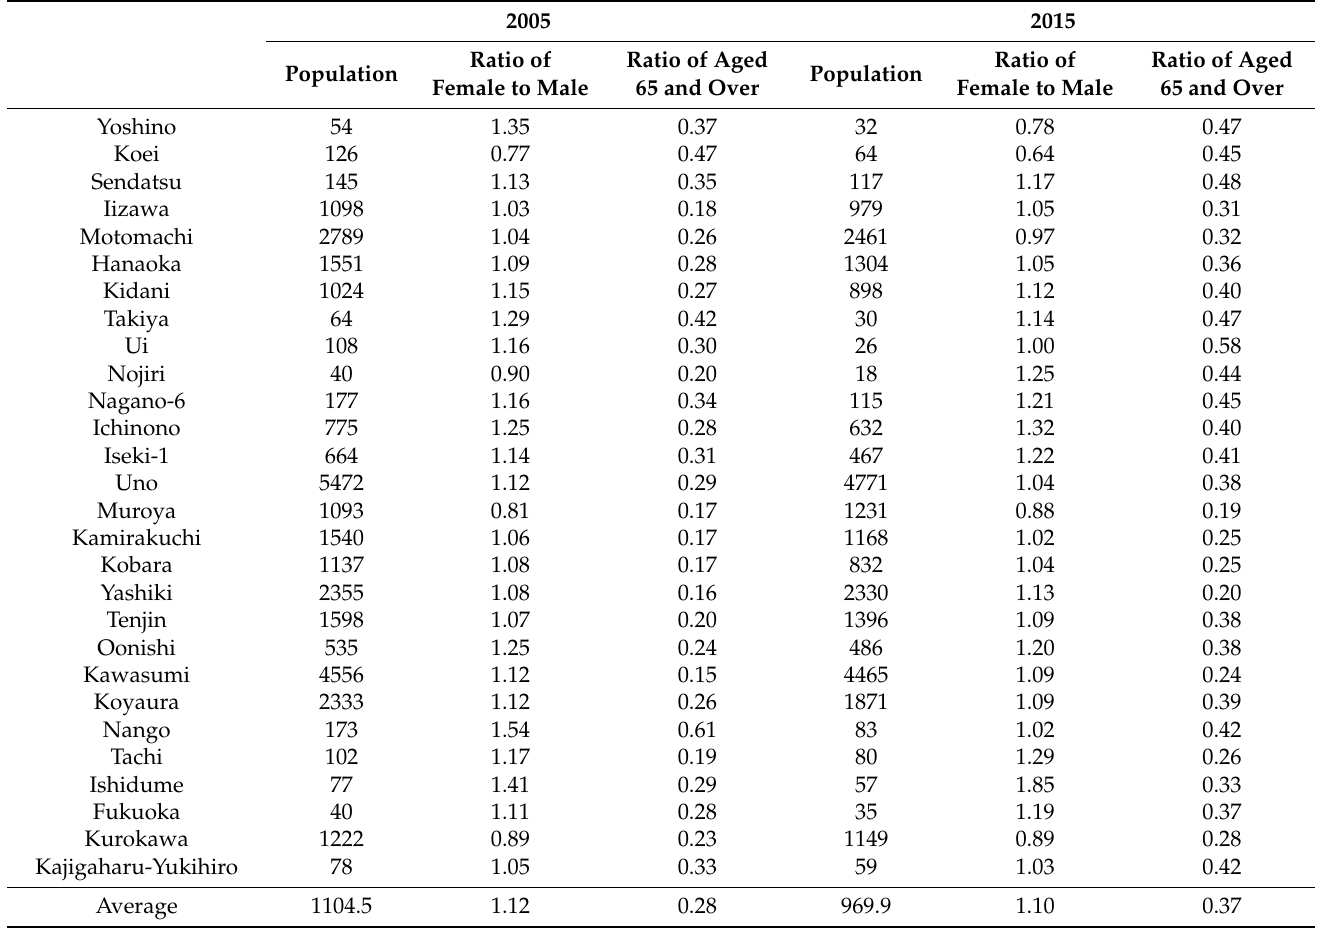
Table 4. Comparison of 2005 and 2015 populations in the study areas. 2005 Population